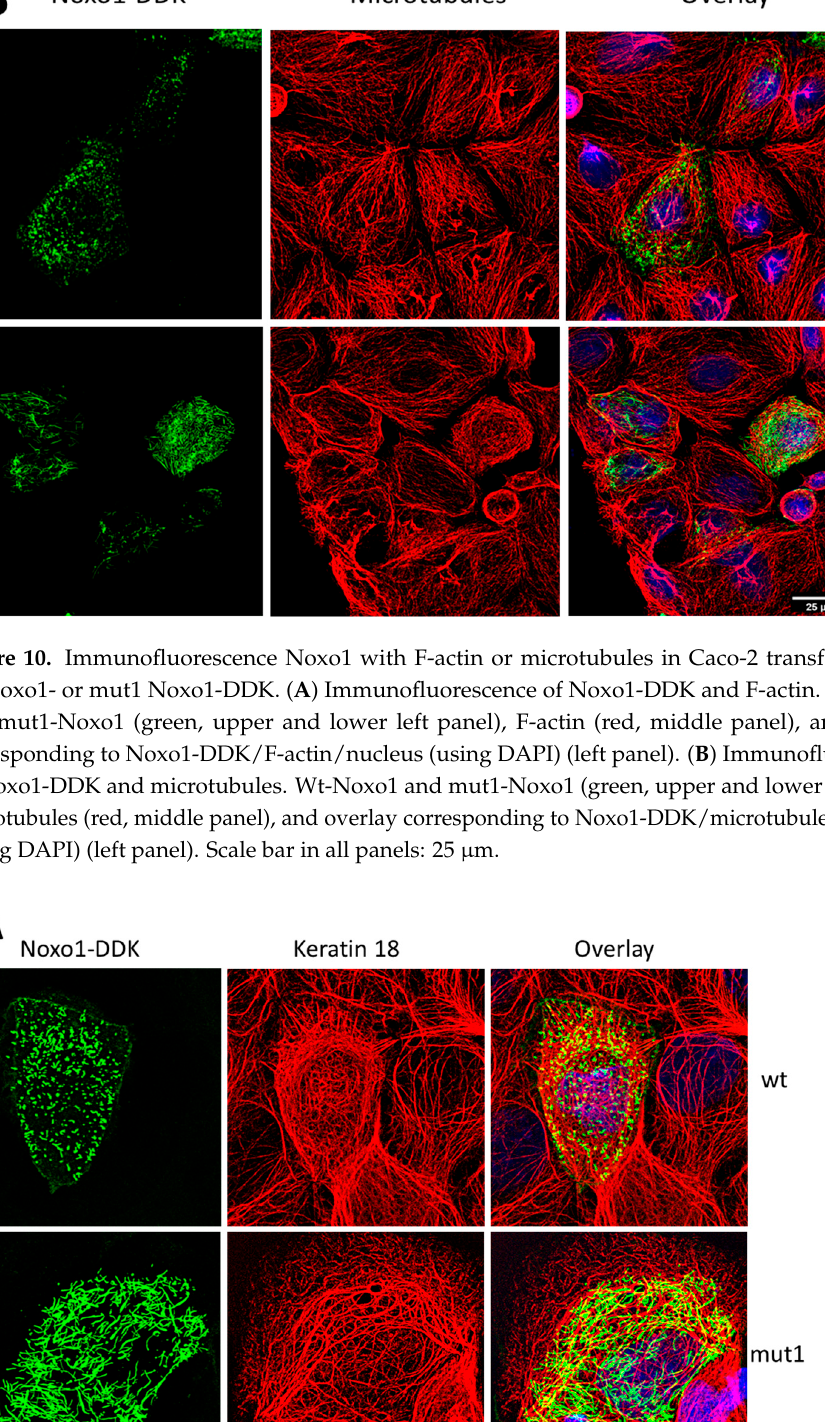
Figure 11. Immunofluorescence Noxo1 with keratin 18 in Caco-2 transfected with wt Noxo1- or mut1 Noxo1-DDK. ( A ) Immunofluorescence wt Noxo1-DDK (left upper panel, green) and keratin 18 (middle upper panel, red). Keratin 18 organization in cells transfected with wt Noxo1-DDK or mut1 Noxo1-DDK assessed with an antibody directed against keratin 18 (red). The overlay upper right panel corresponds to wt Noxo1-DDK/keratin. Immunofluorescence mut1 Noxo1-DDK (left lower panel, green), and keratin 18 (middle lower panel, red). The overlay (right lower panel) cor- responds to mut1 Noxo1-DDK/keratin 18. There is a clear colocalization of Noxo1 with keratin 18 at many spots or sites for either the wt or mut1 form of Noxo1 (yellow). Scale bar in all panels: 25 µm. ( B ) Effect of latrunculin B, F-actin depolymerizing agent on the distribution of Na,K-ATPase, Noxo1, keratin 18 and, GAPDH in soluble and insoluble fractions in Caco-2 overexpressing wt or mut1 Noxo1 lysed in RIPA buffer. The result of the expression of these proteins was analyzed by im- munoblot using DDK antibody for Noxo1 and specific antibodies against Na,K-ATPase, keratin 18, or GAPDH. Na,K-ATPase and GAPDH are mainly present in the supernatant in all conditions and used as a membrane marker and as loading ctl, respectively. Both wt Noxo1- or mut1 Noxo1-DDK are mainly present in the insoluble fraction (pellet), and to a lesser extent, in the soluble fraction (supernatant). These distributions are independent of whether F-actin is intact or depolymerized in all conditions.